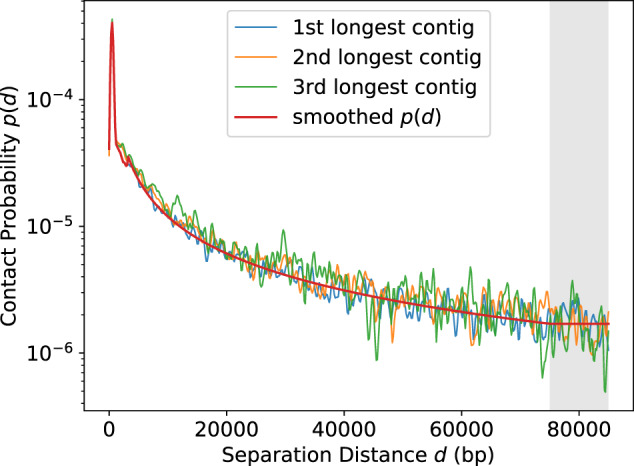
Comparison of contact probability distributions among the longest contig (blue), second longest contig (yellow) and the third longest contig (green). The smoothed distribution calculated from the longest contig is shown by the red line, which is actually used as P(d). This distribution appears to represent a good approximation of the top three distributions. P(d) was set to a constant probability when d> 75 kb, shown as a gray-colored region